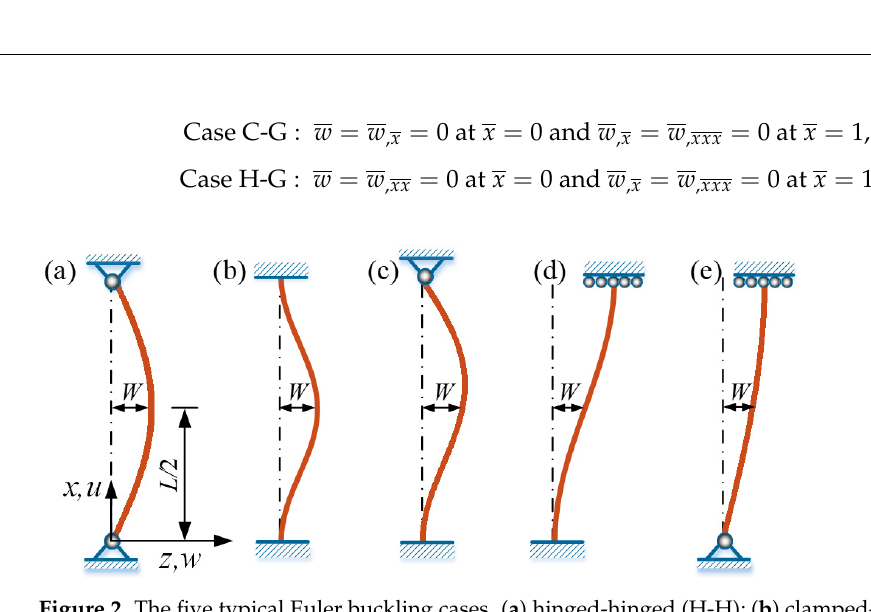
Figure 2. The five typical Euler buckling cases. ( a ) hinged-hinged (H-H); ( b ) clamped-clamped (C-C); ( c ) clamped-hinged (C-H); ( d ) clamped-guided (C-G); ( e ) hinged-guided (H-G). The guided boundary condition G represents that the lateral displacement is not constrained but the rotation is constrained.